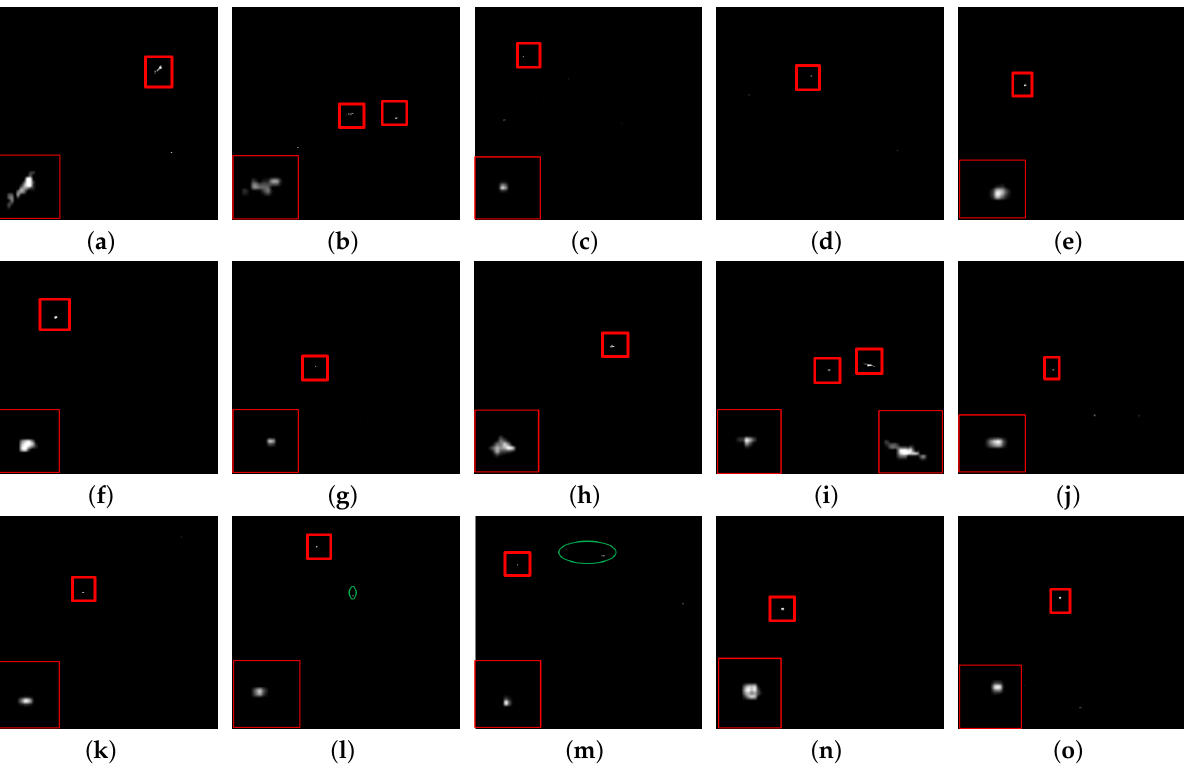
Figure 12. Targets detected in 15 different sequences by the proposed method. ( a – o ) represent the corresponding scenes in Figure